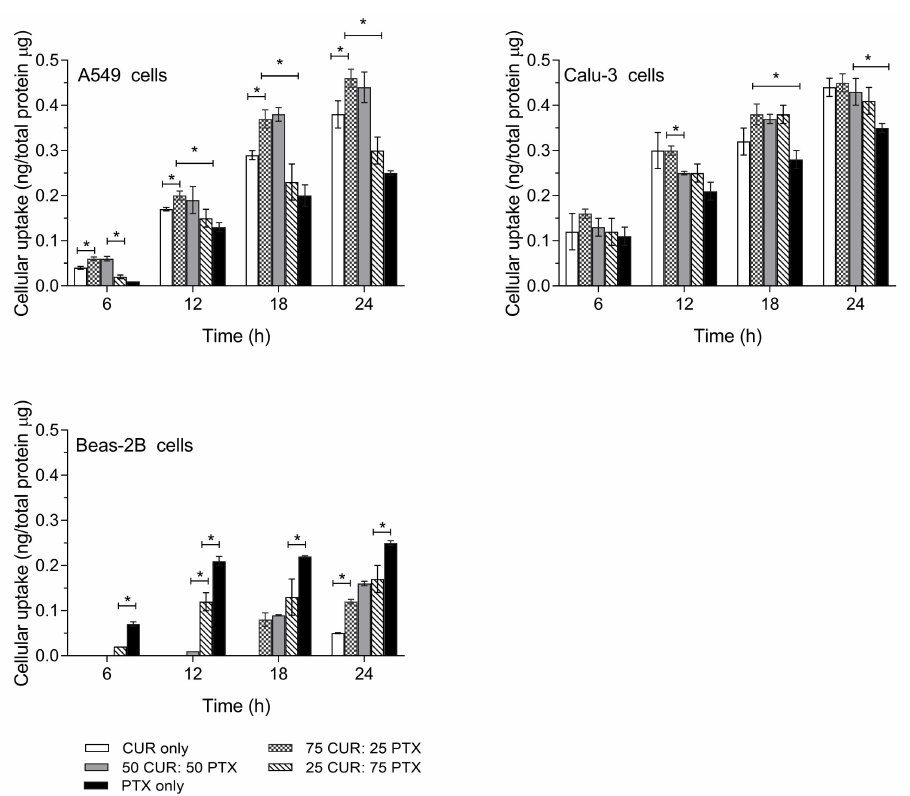
Figure 4. The cellular uptakes of single and combination formulations in A549, Calu-3 and Beas-2B as a function against time. Data are expressed as mean ± SD of three replicates. * Significantly different at p < 0.05 (Tukey post hoc